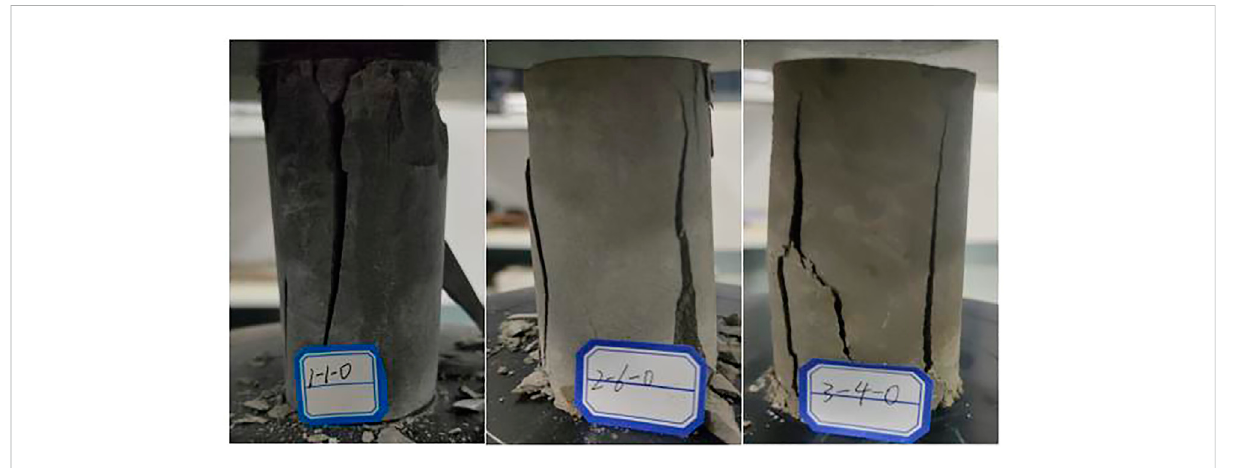
FIGURE 4 Morphology of the fi lling material after damage.